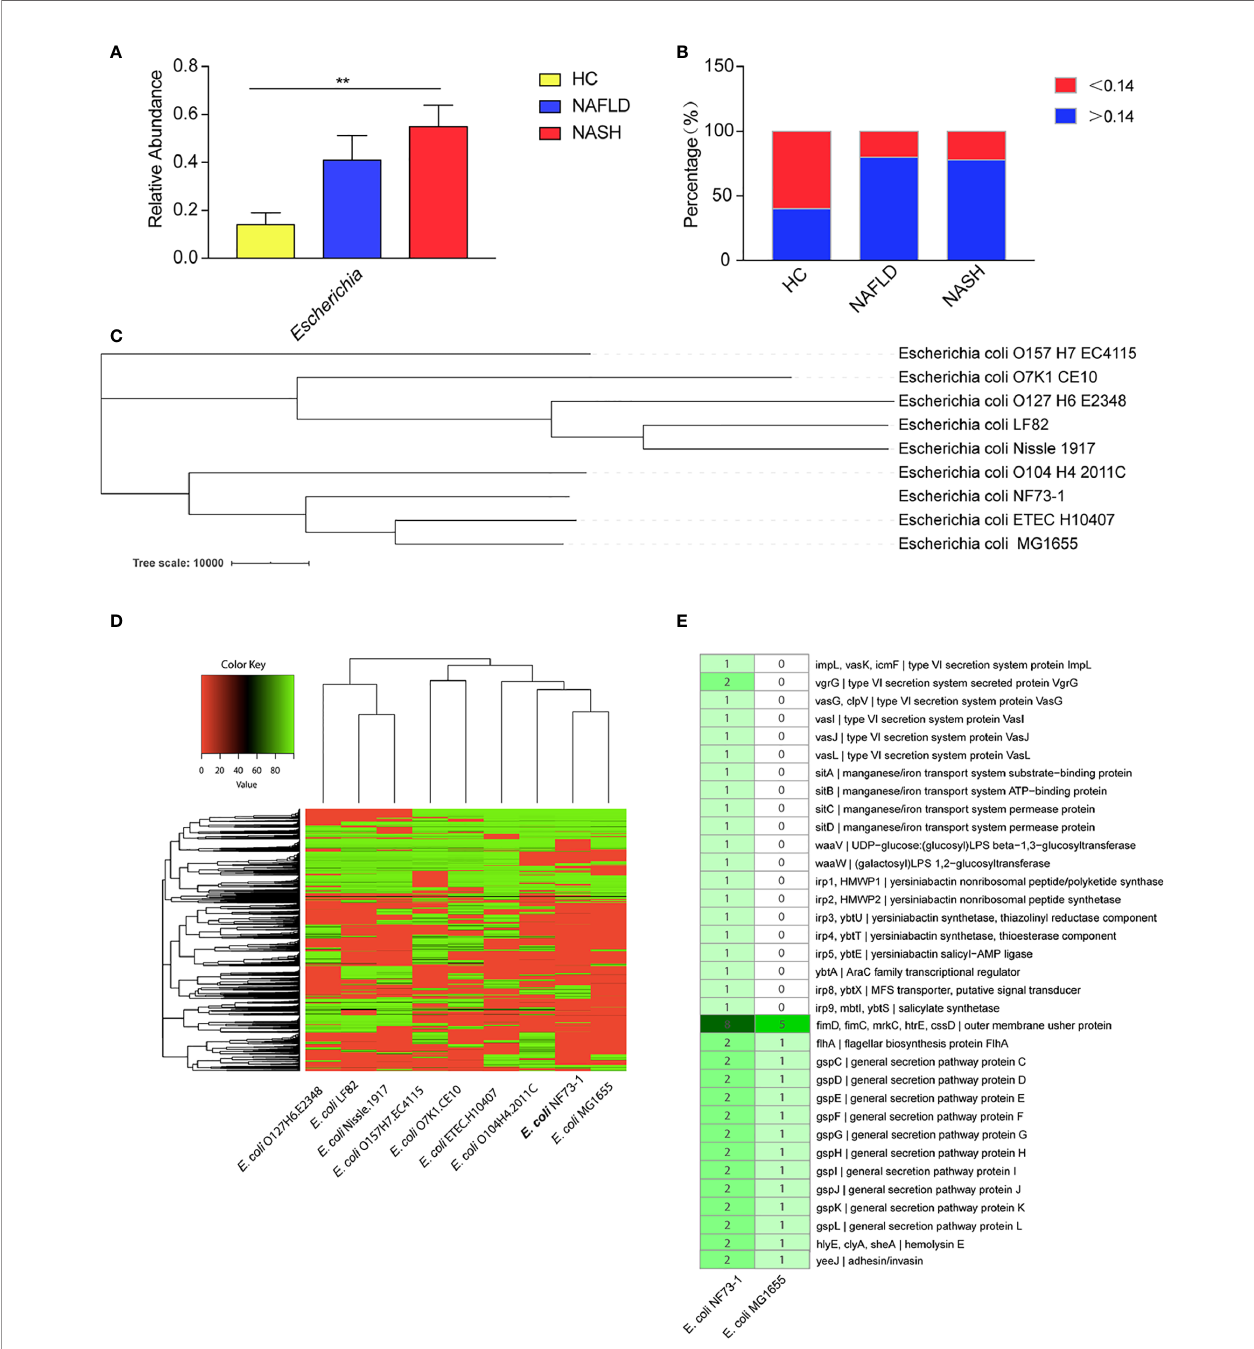
FIGURE 1 | E. coli – speci fi c comparative genomic analysis. (A) Comparison of the Escherichia abundance at the genus level among NASH and NAFLD patients and healthy subjects. (B) High-abundance (>0.14) Escherichia colonized percentage of the healthy controls, NAFLD and NASH patients. (C) A phylogenetic tree was constructed by TreeBeST using the neighbor-joining (NJ) method. (D) Cluster heat map of 9 E. coli genomes. The cluster tree of dispensable genes is represented on the Y-axis and the E. coli genomes are listed on the X axis ( E. coli . O127H6.E2348, E. coli . LF82, E. coli . Nissle.1917, E. coli. O157H7.EC4115, E. coli. O7K1.CE10, E . coli . ETEC.H10407, E. coli . O104H4.2011C, E. coli .MG1655 and E. coli. NF73-1). The color key representing the degree of similarities and differences of the genomes based on dispensable genes. A detailed description of genomes can be found in Table S1 . (E) Comparative genomics of E. coli NF73-1 and E. coli MG1655 in KEGG general functional annotations. Gene names are represented on Y-axis and the E. coli genomes are listed on the X-axis. The color key representing the degree of differences of the genomes based on the presence or absence of genes. Detail description of genomes can be found in Table S3 . Data are calculated as the mean ± SEM, n = 9 – 10 per group. **p <0.01 (one-way analysis of variance between multiple